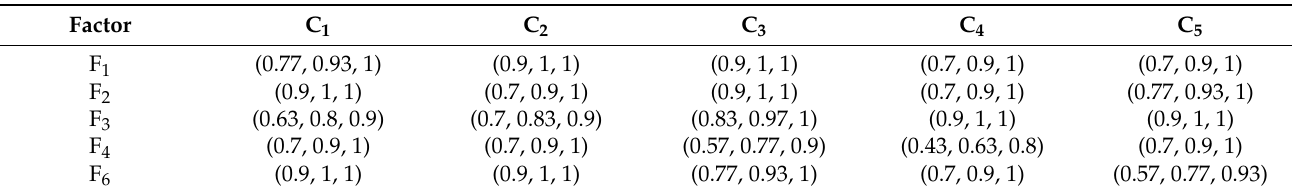
Table 19. The normalized fuzzy decision matrix.